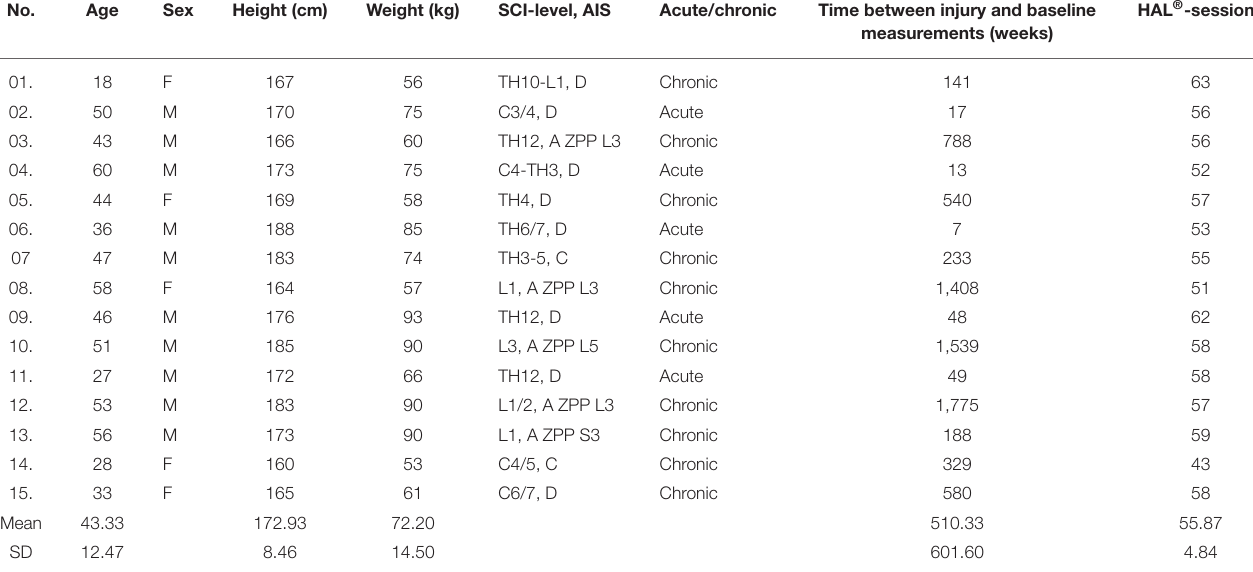
TABLE 1 | Participants